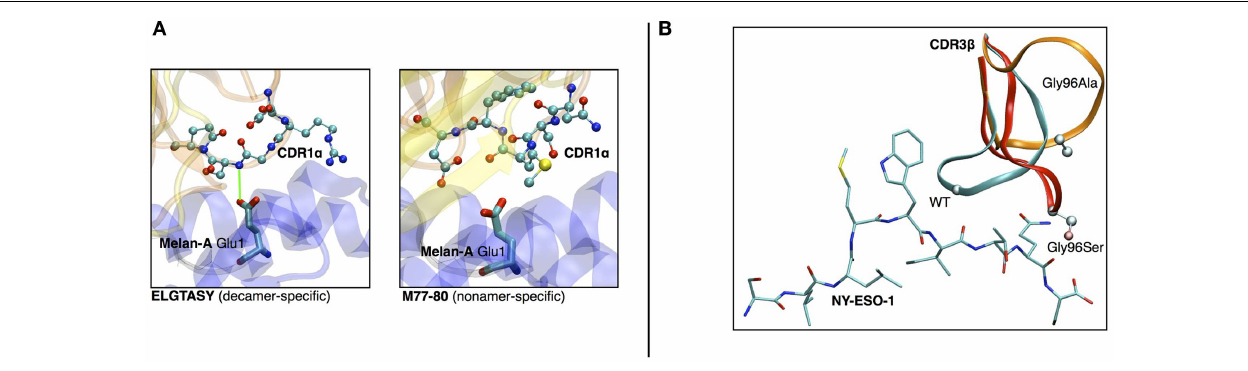
FIGURE 6 | (A) Structural differences between nona- vs. decamer-specificTCR bound to Melan-A(ELA)/HLA − A ∗ 0201.The green line identifies the hydrogen bond that is formed between CDR1 α and Glu1 of the peptide. No favorable interactions were identified between M77-80 and the decamer variant of Melan-A. (B) In silico mutation results in NY-ESO-1 repertoire.The dramatic structural rearrangement of the mutated CDR3 β confirms the importance of the central